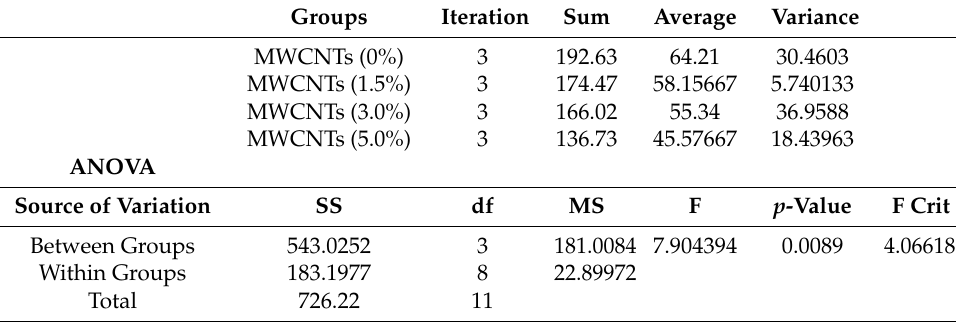
Table 6. Water absorption values of MWCNTs-UF MDF for various iterations.